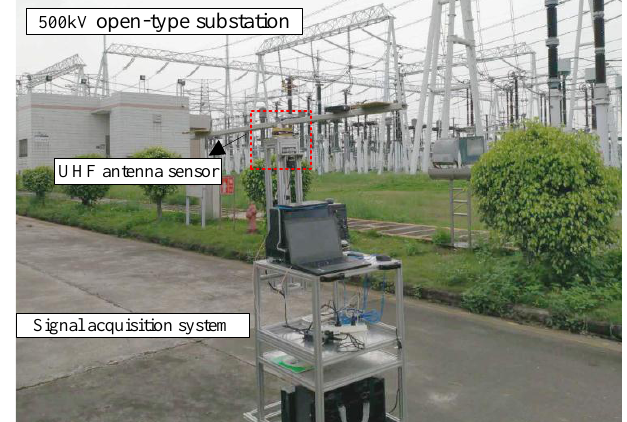
Figure 11. Field test platform.